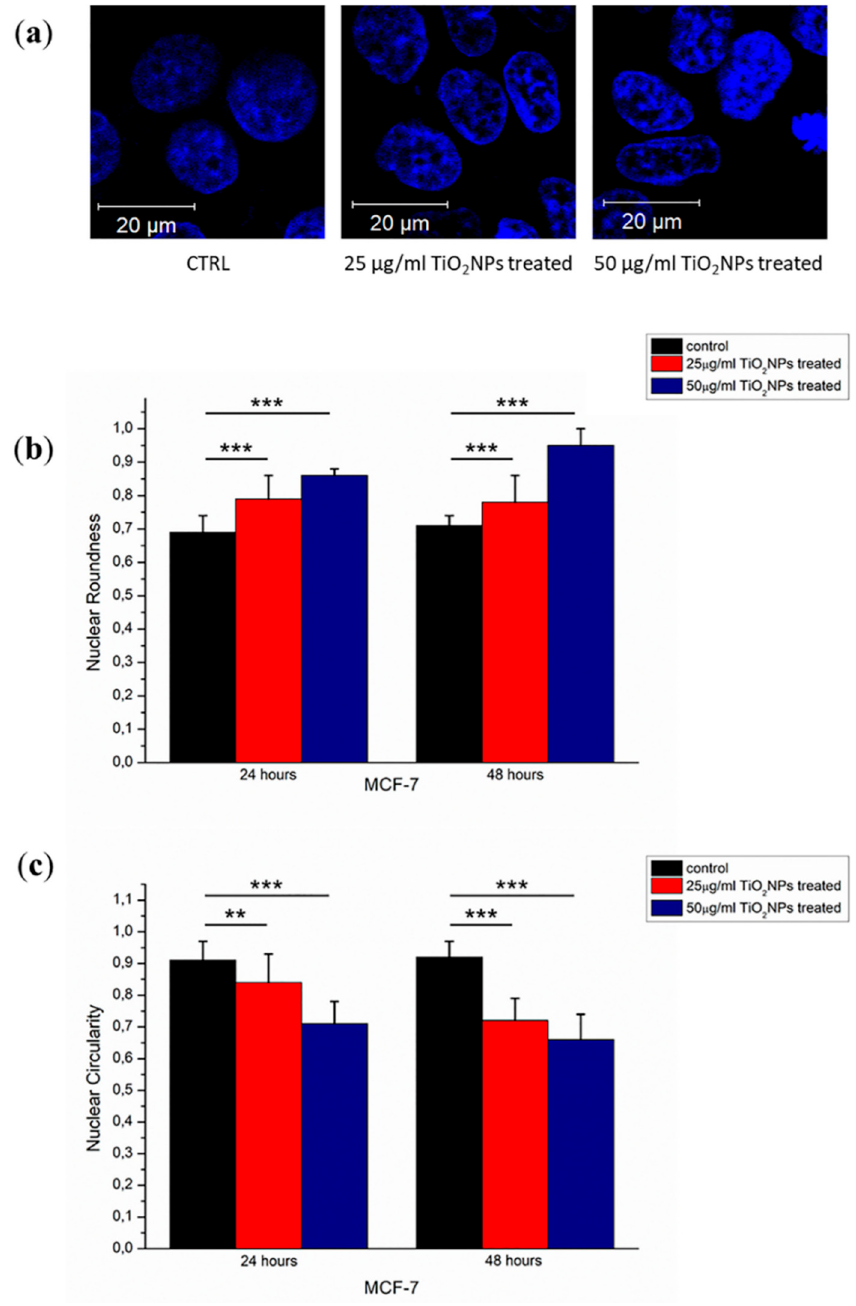
Figure 7. Representative confocal images of nuclei ( a )Histograms reported the mean values and their respective standard deviation of nuclei circularity ( b ) and roundness ( c ). The statistical significance of results respect to control cells was evaluated by t test, and reported in histograms (** p < 0.01 and *** p < 0.005.).